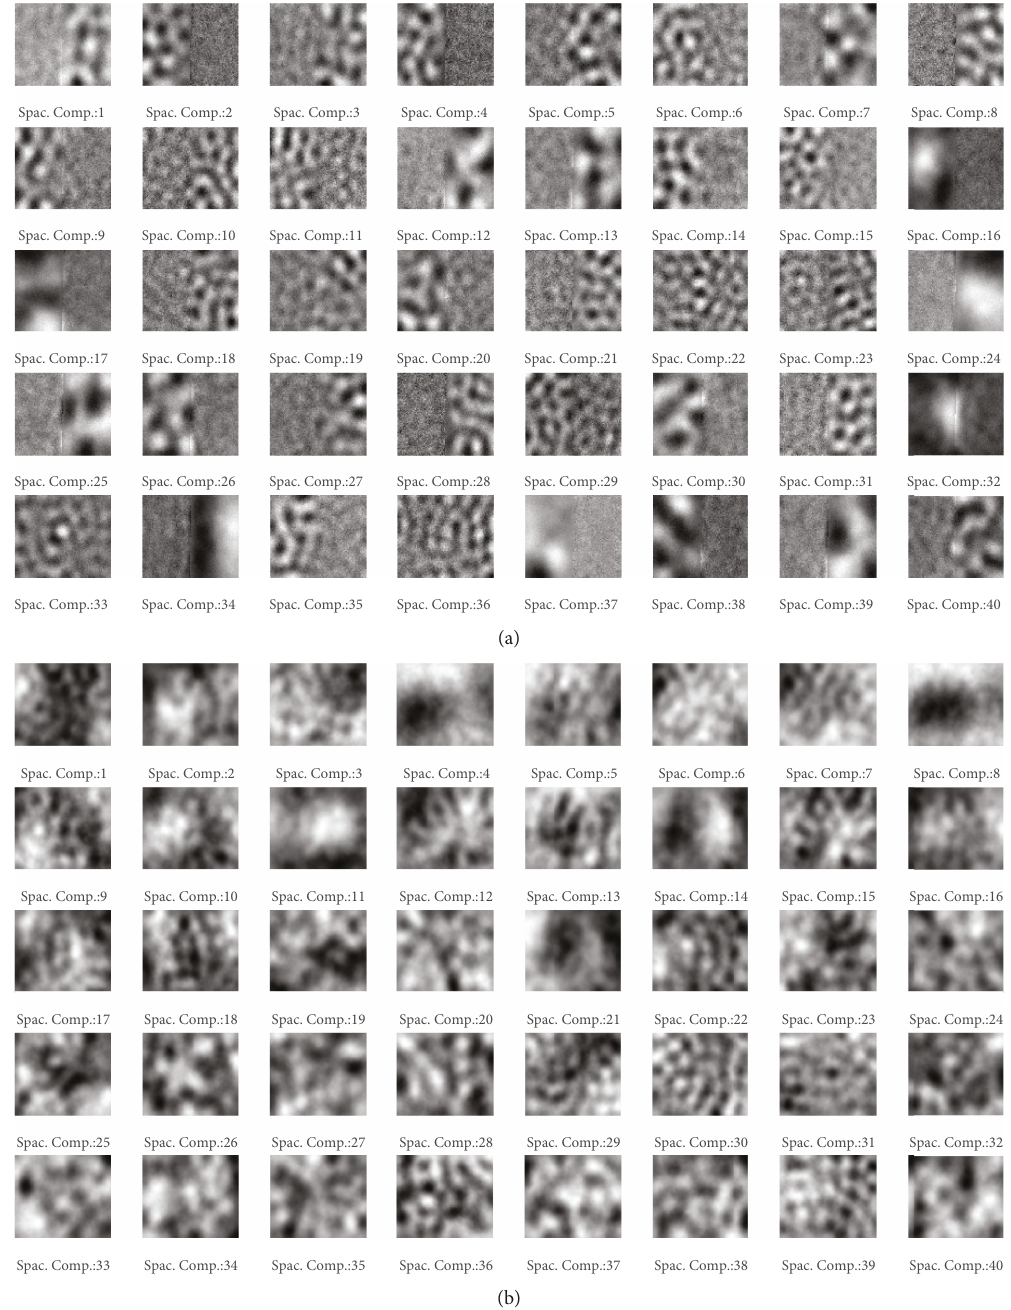
Figure 5: First 40 (out of 120) spatial components of PARAFAC model from 10% observed values using StrProxSGD (a) and from full values using ALS